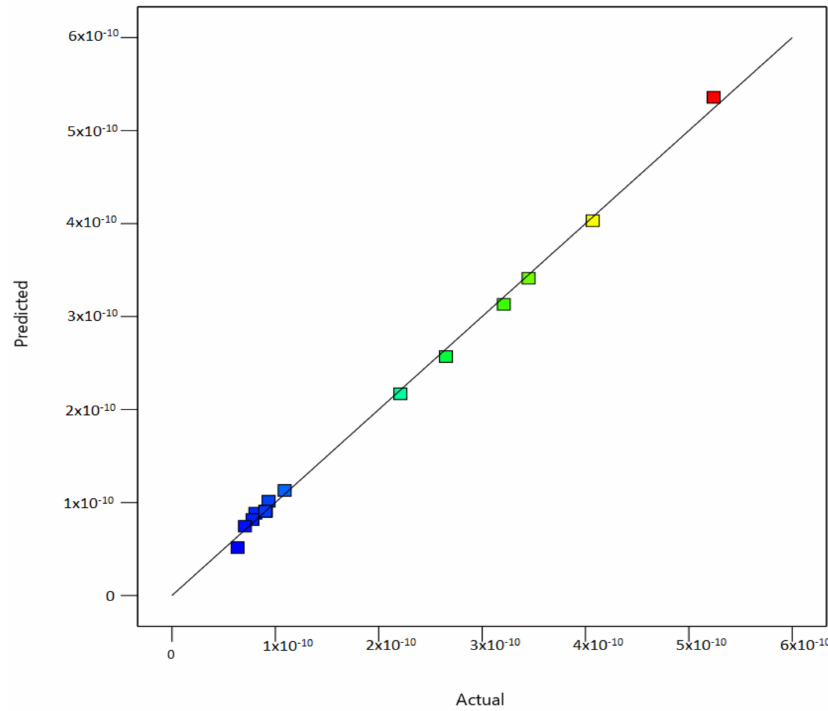
Figure 6. Plot of predicted response vs. actual value.